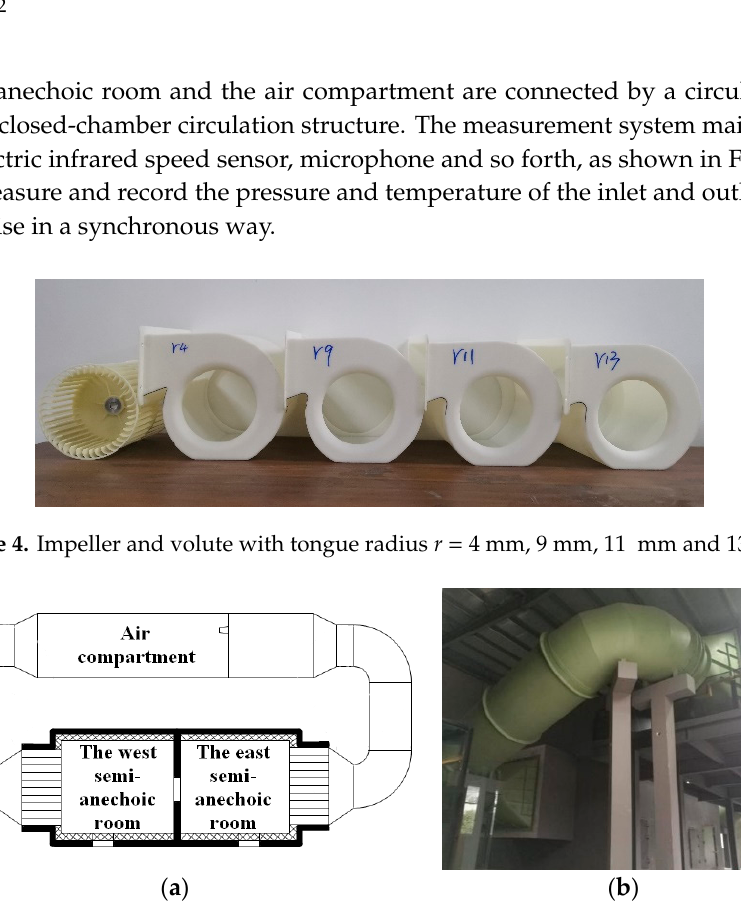
Figure 5. ( a ) The schematic diagram, ( b ) photo of the facility.